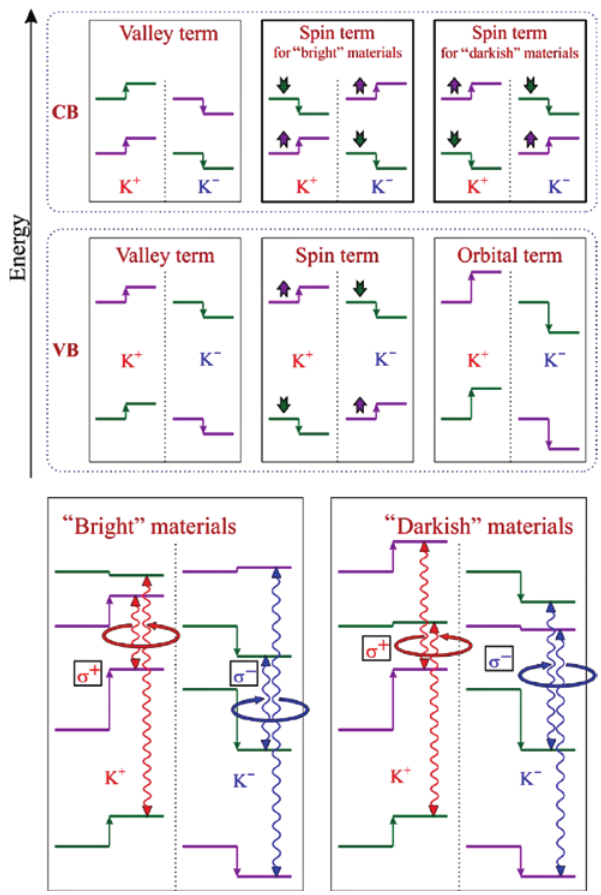
Figure 7: Pictorial representation of the influence of the valley, spin, and orbital terms on the energy of electronic states in an S-TMD monolayer. The arrows between the states indicate the direction in which the particular state is shifted when the magnetic field is applied. The color code is used to indicate the spin of the states (purple for spin-up and green for spin-down states). Furthermore, in the cartoons for spin terms, additional arrow symbols are used to more clearly demonstrate the spin properties. The two possible spin configurations in the conduction band have also been highlighted in order to emphasize the origin of the two sets of optical selection rules for optically bright and “darkish” materials. In the bottom part, the two diagrams show a complete energetic landscape in a magnetic field for both types of materials. The optically active transitions between the valence and conduction states of the same spin are marked, and their helicity is reflected by the following color code red for σ + polarized transitions and blue for σ − polarized